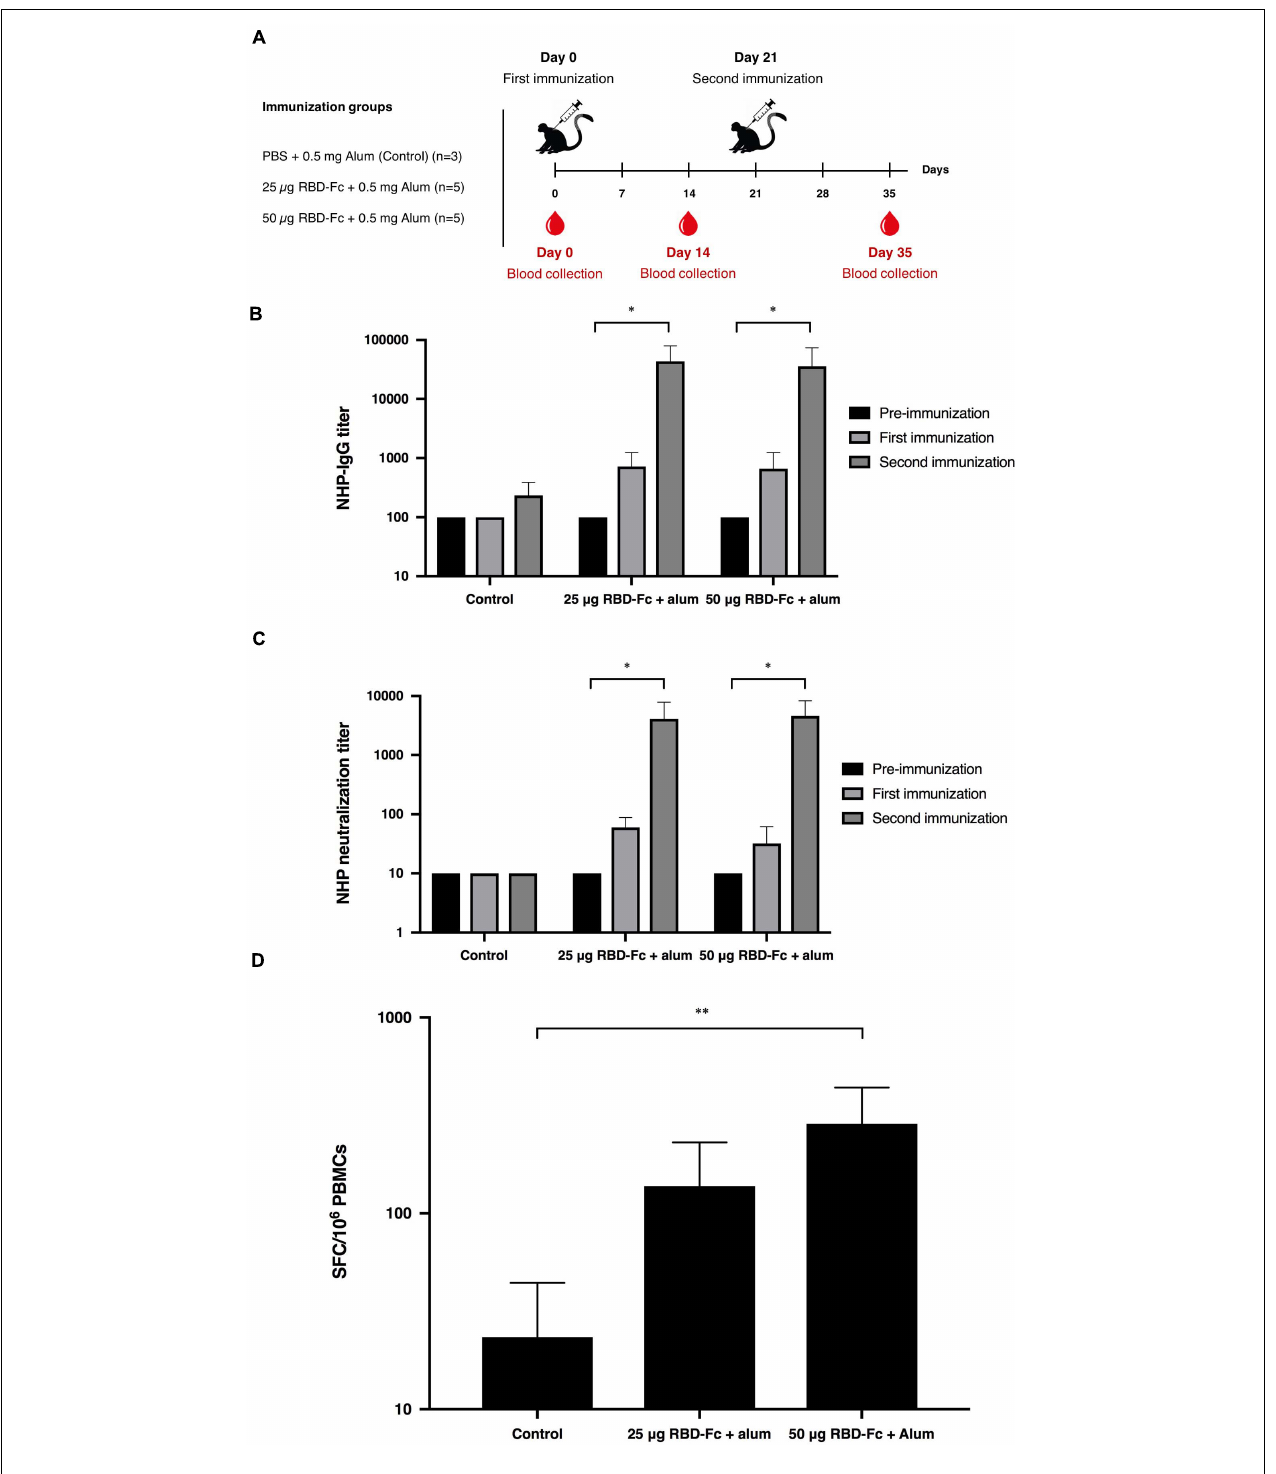
FIGURE 5 | Immunogenic studies in non-human primates ( Macaca fascicularis ). Experimental design of immunogenicity studies in non-human primates. Thirteen juvenile-adult non-human primates were separated into 3 groups; Control group was immunized with PBS adjuvanted by alum ( n = 3) and two experimental groups were immunized with 25 and 50 µ g SARS-CoV-2 RBD-Fc along with alum adjuvant ( n = 5 per group). All non-human primates were intramuscularly injected either with PBS or plant-produced RBD-Fc for 3 weeks interval (on day 0 and 21). The sera were collected on day 0 and 14 after each boost (A) . Serum specific IgG response in non-human primates were determined by ELISA (B) . Virus neutralizing titer of RBD immunized non-human primate sera against live SARS-CoV-2 were evaluated (C) . The functional profiles of SARS-CoV-2 RBD-specific T-cell responses expressing in non-human primate peripheral blood mononuclear cells immunized with plant-produced RBD-Fc adjuvanted with alum on day 14 after second immunization (D) . ∗ p < 0.05; ∗∗ p < 0.01; ∗∗∗ p < 0.001; ∗∗∗∗ p < 0.0001.